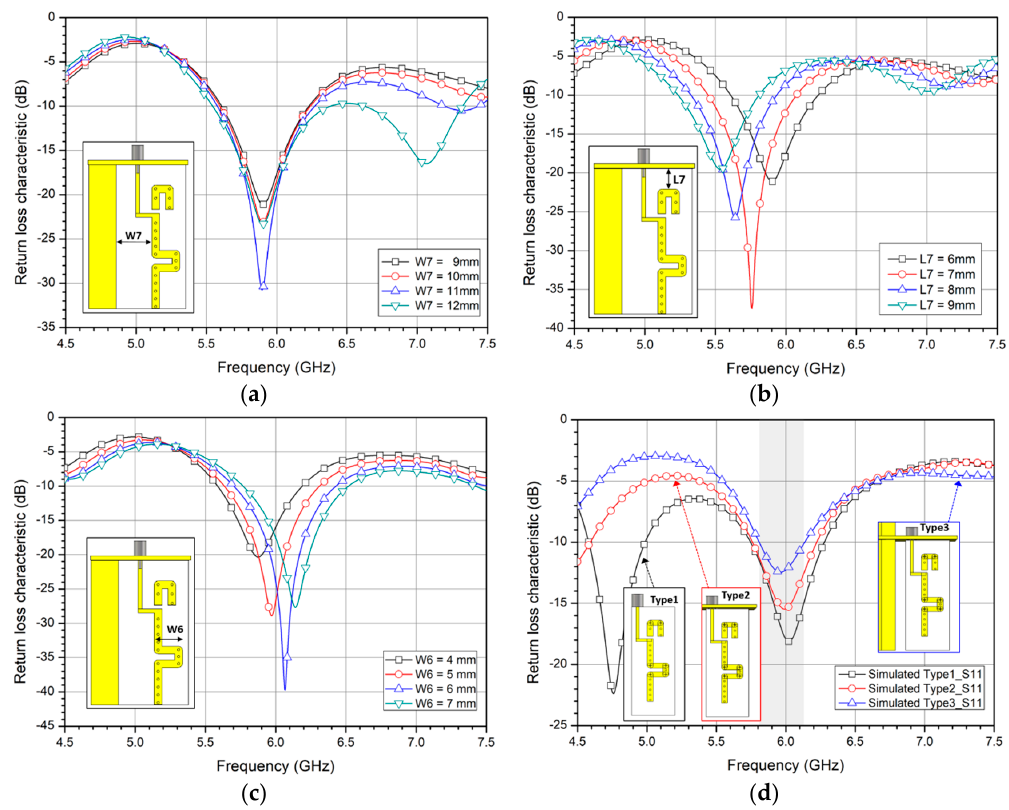
reflector configurations.